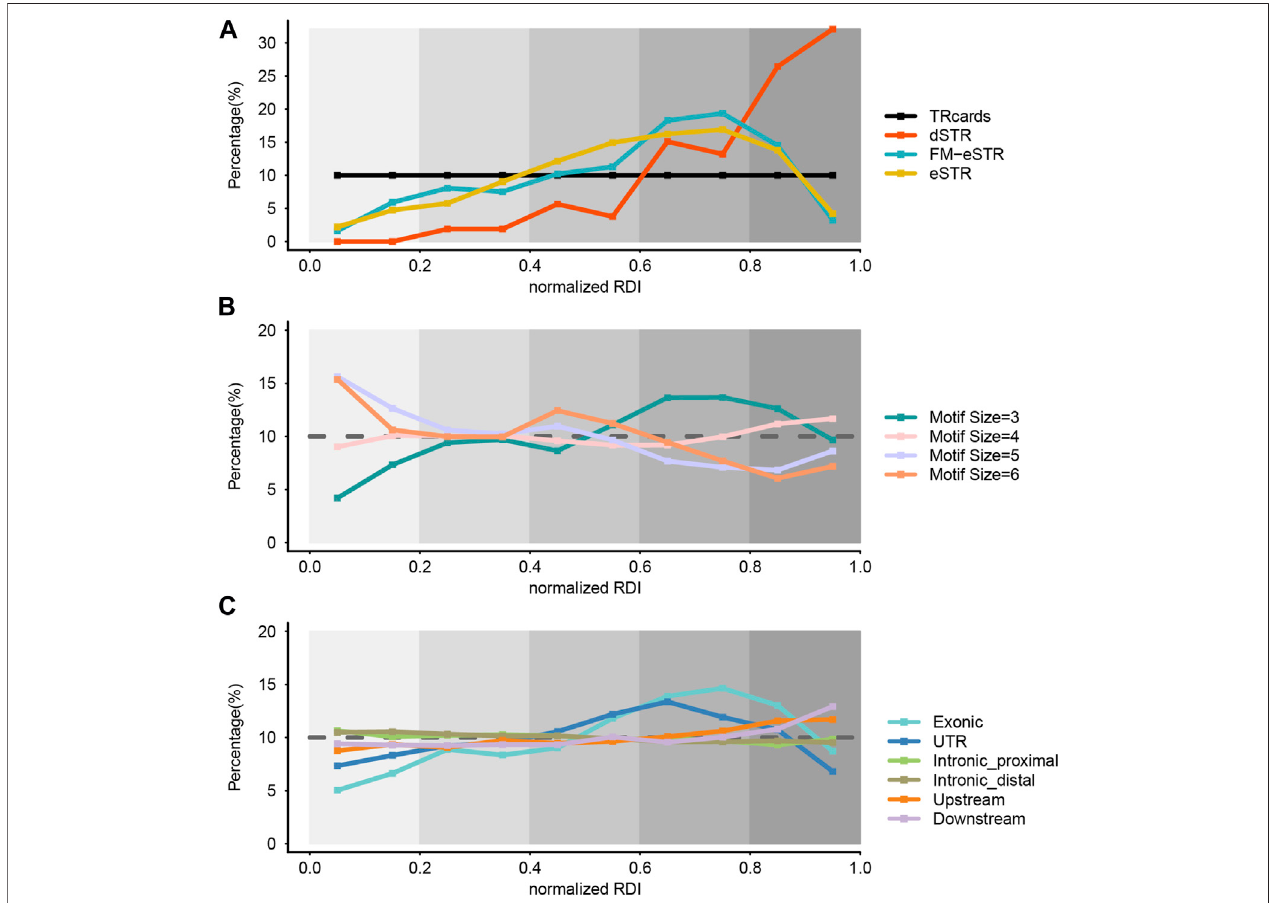
FIGURE 3 | Genome-wide evaluation of STR variability. (A) The distribution of STR variability in the dSTR subset, eSTR subset, and FM-eSTR subset. TRcards = ourentireSTRdataset,dSTR=disease-associatedSTR,eSTR=expressionSTRs,FM-eSTR= fi ne-mappedeSTRs. (B) ThedistributionofSTRvariabilityinthedifferent motif size subsets. (C) The distribution of STR variability in the different genomic region subsets. In all panels, the x -axis gives the normalized RDI value and the y -axis gives the percentage of STR loci. Normalized RDI = normalized repeat dynamic index. We refer to the STR with normalized RDI score at 0 – 0.2, 0.2 – 0.4, 0.4 –